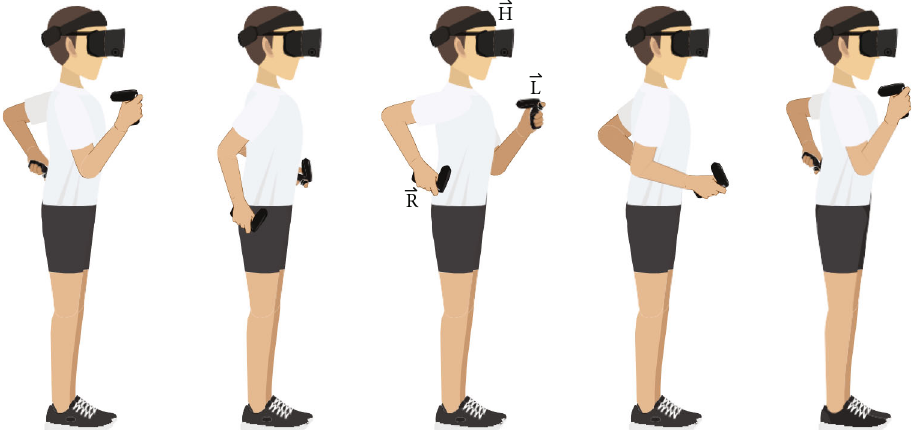
Figure 2: Virtual running with the ArmSwing posture.